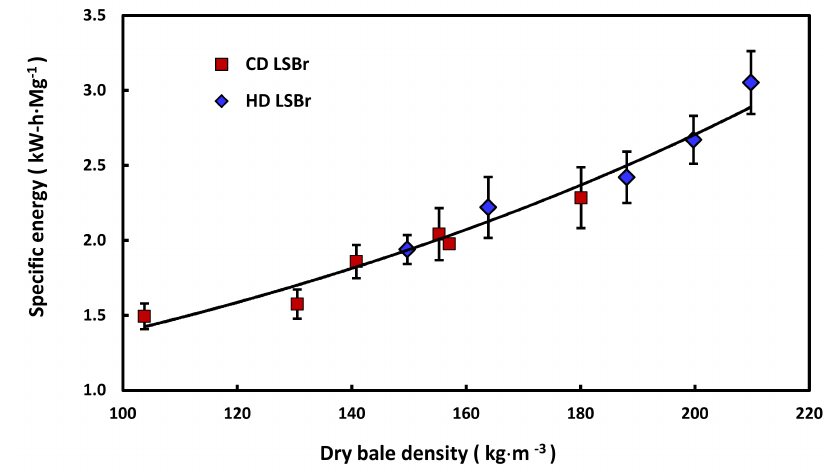
Figure 2. Specific energy requirement vs. bale density (both on a dry basis) for combined switchgrass and native grass data from the high density (HD) LSBr and combined reed canarygrass and switchgrass data from the conventional density (CD)